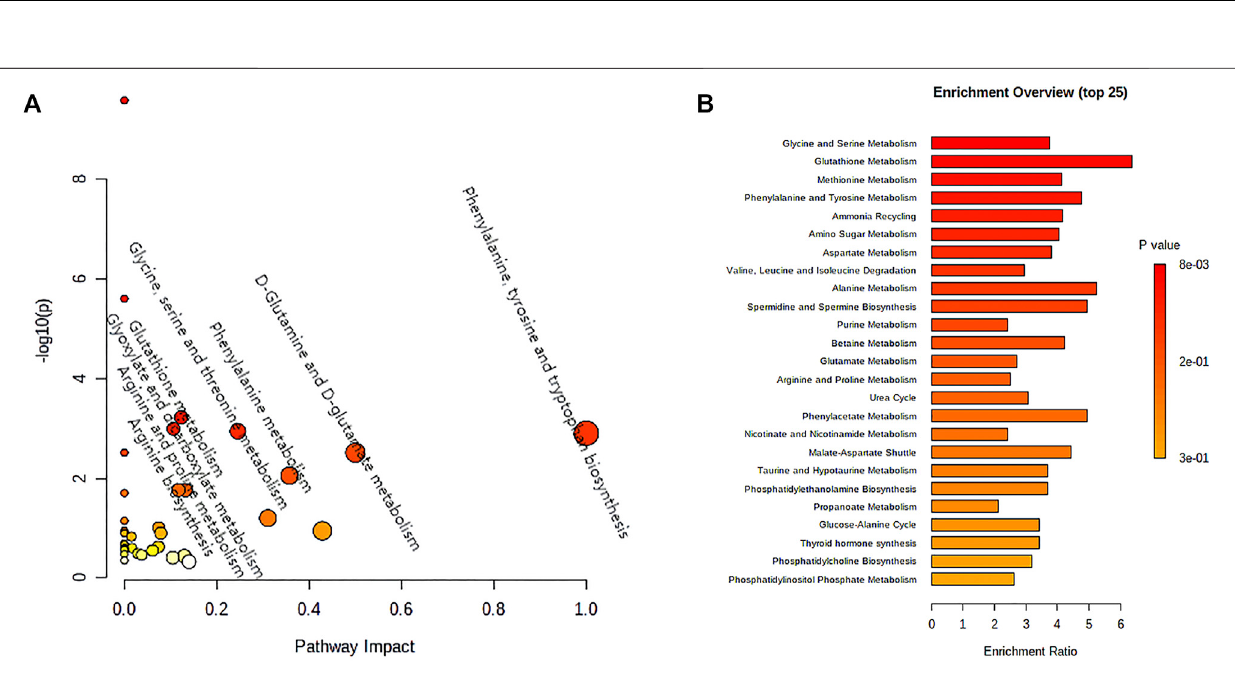
FIGURE 5 | MetPA analysis of (A) the metabolic pathway and (B) the enrichment of metabolite sets.